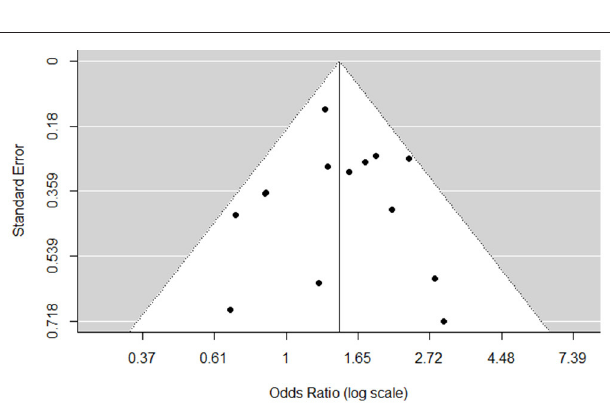
FIGURE 4 | Funnel plot for the odds of the association between parental mental illness and CRIT after removal of outliers.